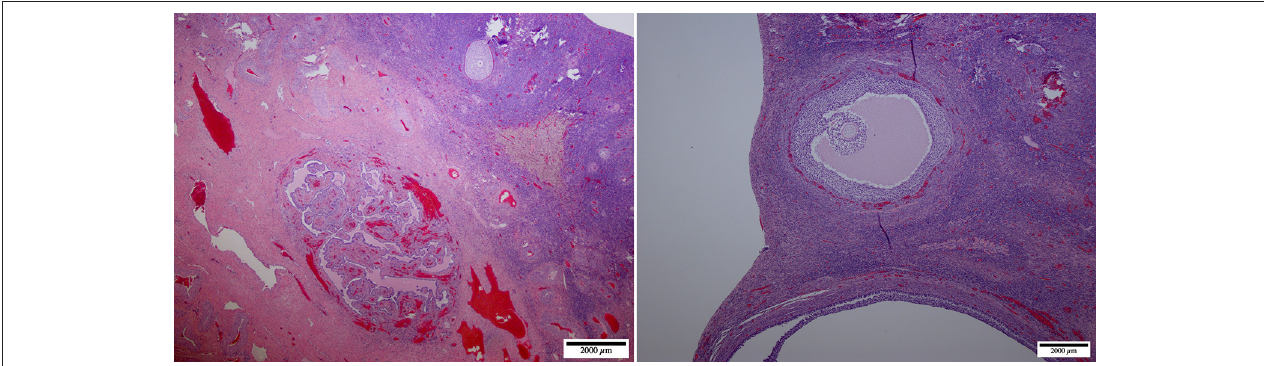
FIGURE 8 | Ovarian dysplasia: micrographs at lower (left, × 20) and higher (right, × 40) magnification of the ovary. This case presented a poorly differentiated medulla. The cortex presented occasional primordial and primary follicles suggesting premature follicular reserve exhaustion [reclassified as premature ovarian insufficiency according to